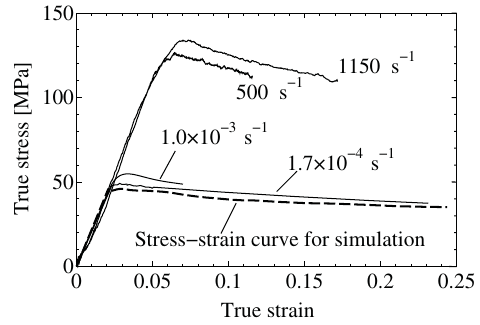
Fig. 3. True stress – true strain curves for PLLA / PCL = 80 / 20.